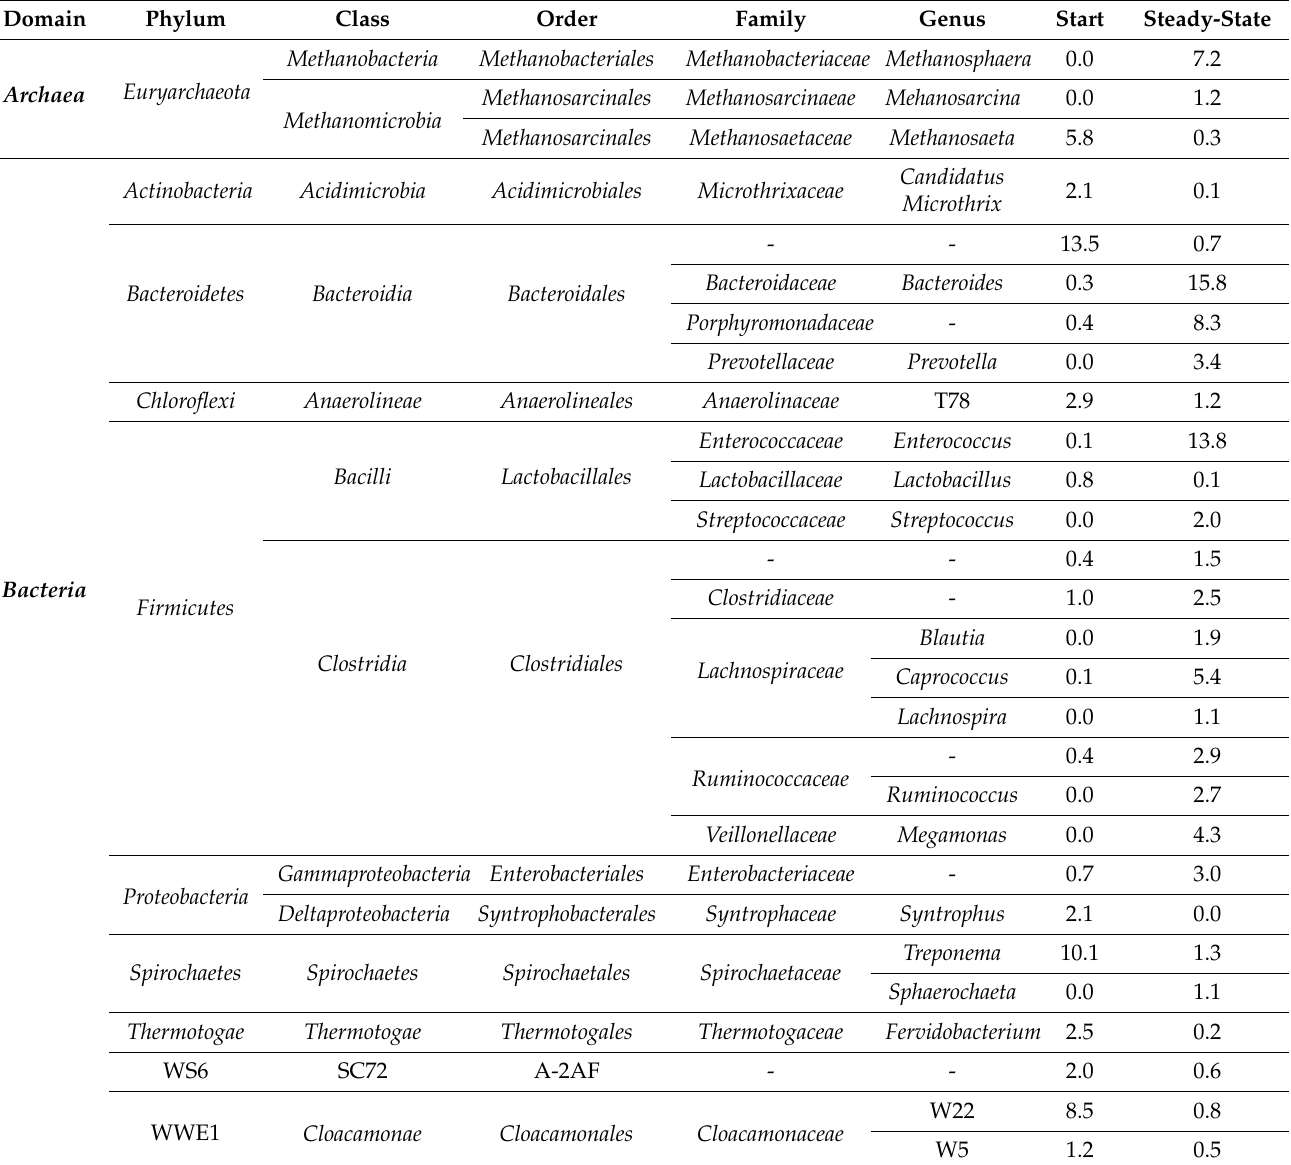
Table 5. The main types of microorganisms identified in samples taken at the beginning and in a steady state of DF, carried out in a semi-continuous system at the OLR of 5 gVS/(L × d) and the HRT of 5 d.